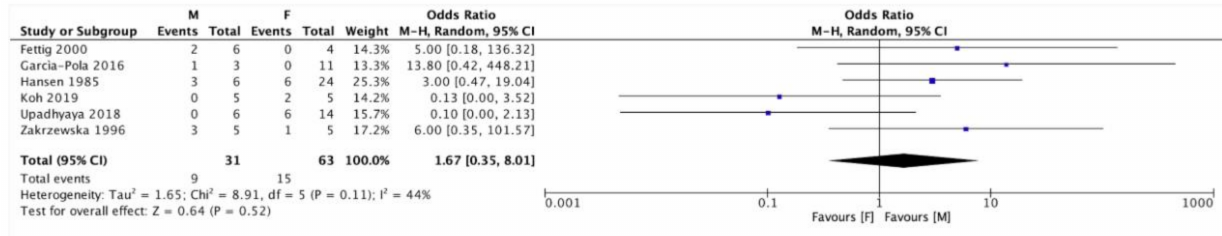
Figure 5. Forest plot relating to the distribution or oral verrucous carcinomas (OVC) in male (M) and female (F)